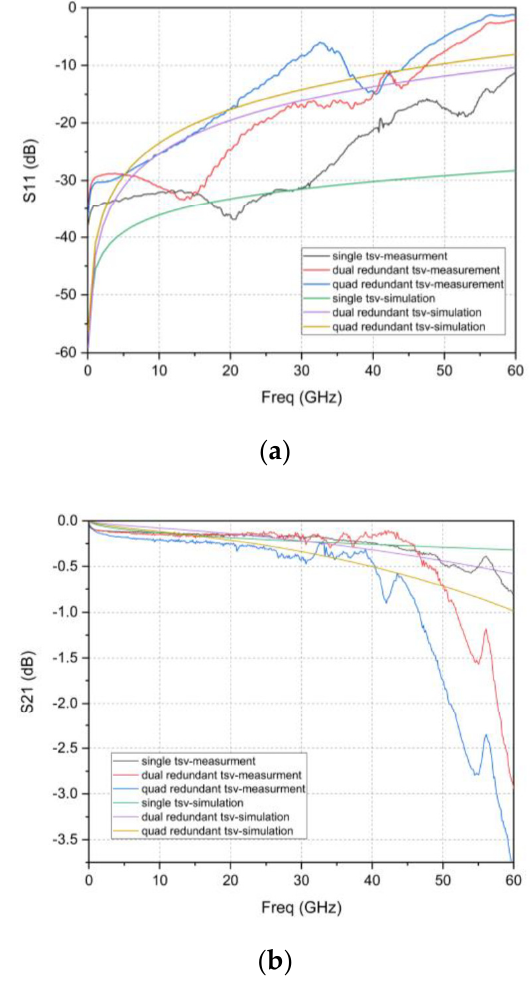
Figure 14. TSV interconnects S 21 parameter measurement results and simulation results of the equivalent lumped components models: ( a ) S 11 ; ( b ) S 21 . Table 4. Comparison RF TSV for high frequency applications.